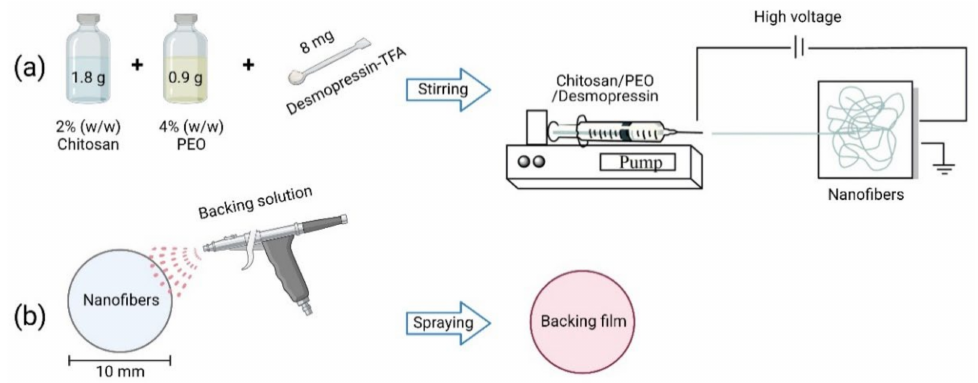
Figure 4. Preparation of the nanofiber–film hybrid system. ( a ) Electrospinning of chitosan/PEO na-nofibers with desmopressin as described in Section 3.2. ( b ) Spraying of film on nanofibers as described in Section 3.3. Created by